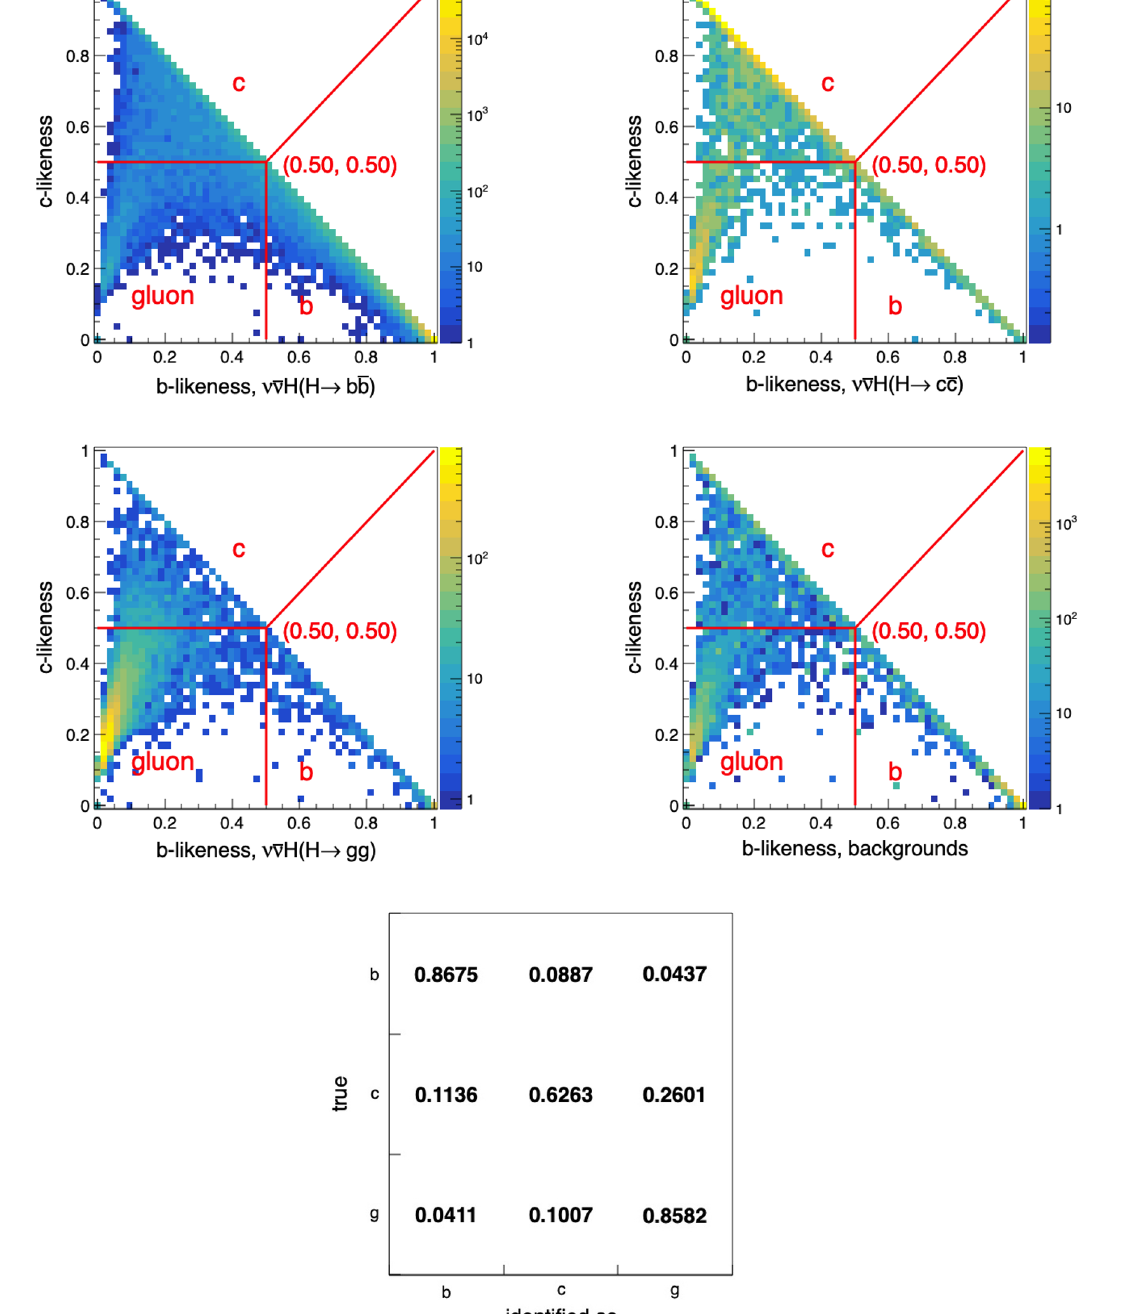
¯ b ) (top left), ν ¯ νH ( H → c ¯ c ) (top